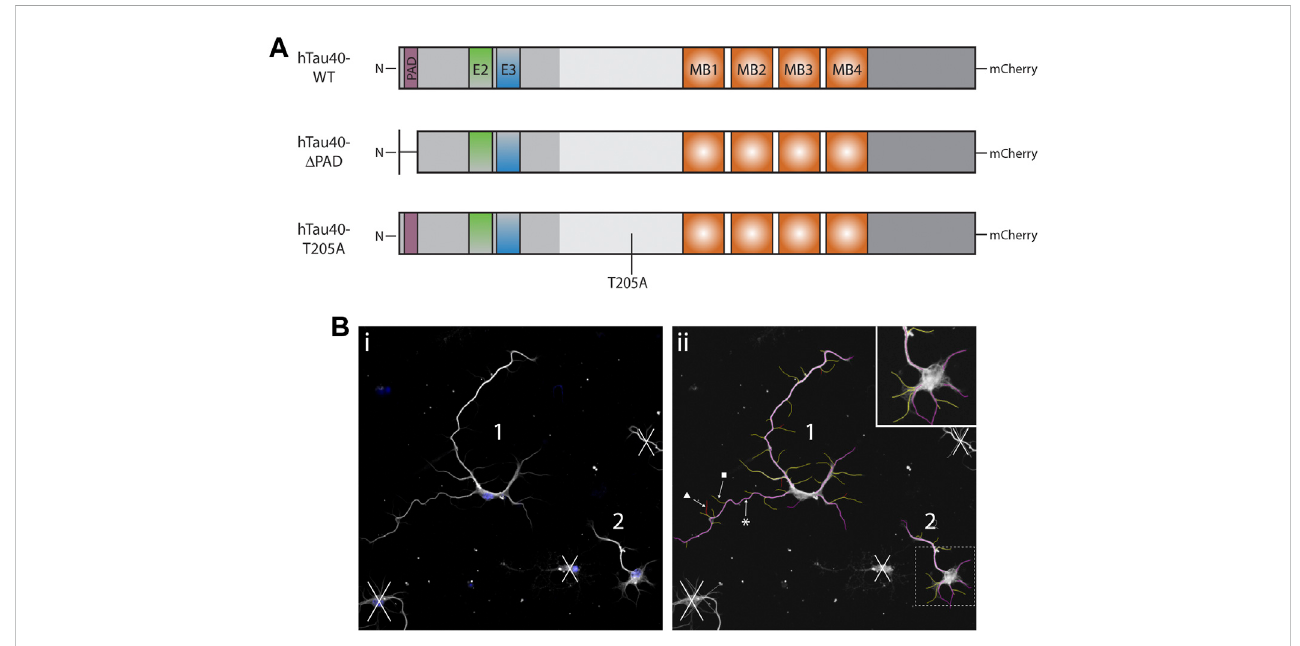
FIGURE 1 Schematics of DNA constructs used for transfection and representative outgrowth images. (A) Schematics of full length hTau40 DNA used for transfection of tau KO hippocampal. Neurons were transfected 16 – 18 h after plating and maintained in culture for a further 72 h. (B) 1) Representative image before neurite measurement. Blue: DAPI, White: β 3-tubulin). All living neurons, judged by nucleus and tubulin integrity, fully contained in the image were identi fi ed and numbered prior to neurite measurement. 2) Representative image of tubulin immunocytochemistry after neurite measurement with the NeuronJ plugin. All neurites and branches are measured before being characterized as primary (magenta, *), secondary (yellow, ■ ), or tertiary (red, ▲ ).